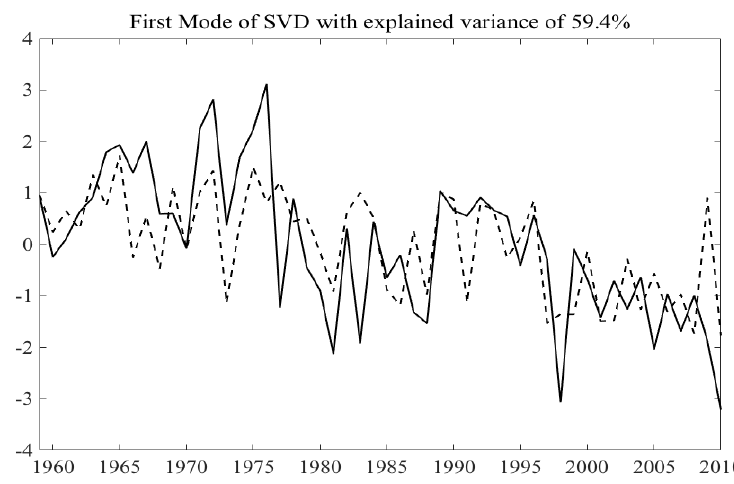
Figure 4. Time series of the mass balance of Glacier No. 1 and climatic indices in the first mode of SVD. Table 2. Heterogeneous correlation between the mass balance of Glacier No. 1 and climate indices. Mode Glacier No. 1